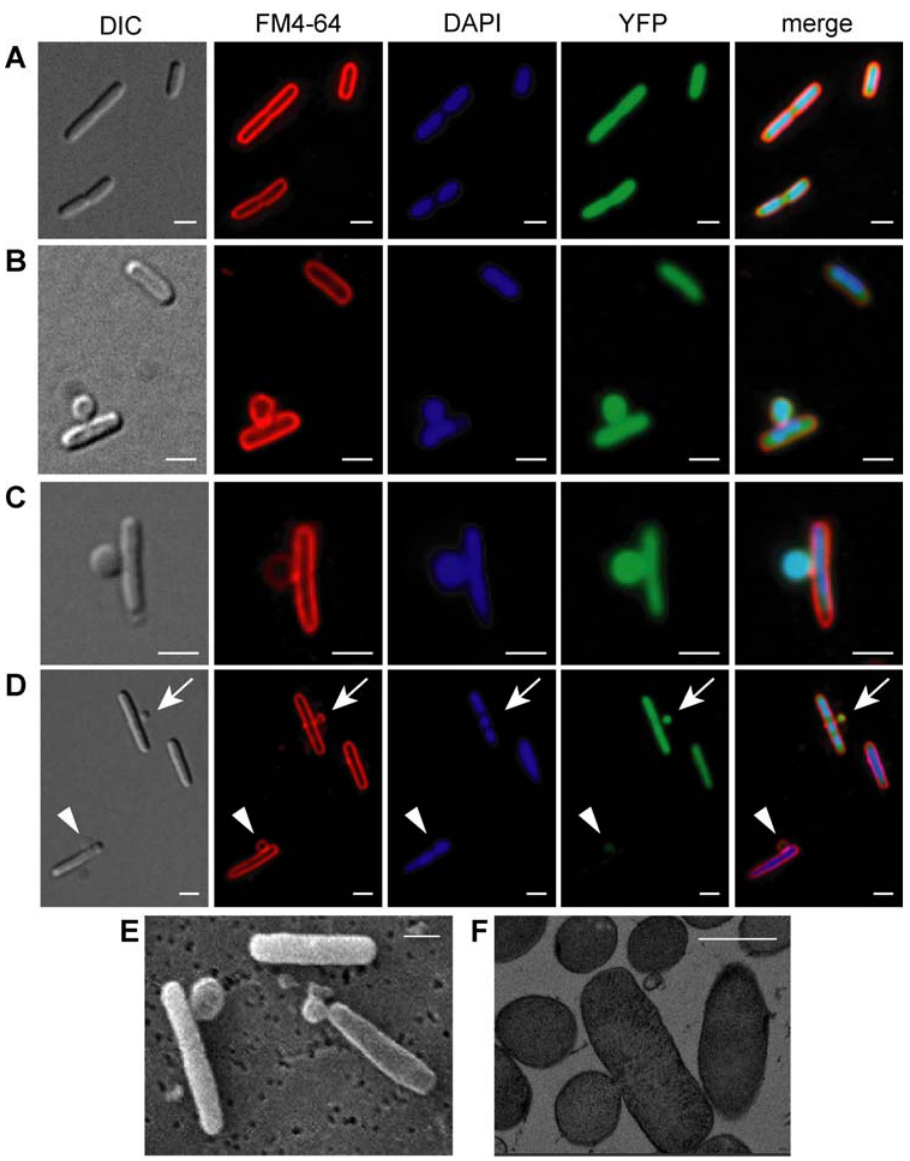
Figure 6. Cell envelope defects resulting from inhibition of s E . Cultures of SEA007 and SEA008 were grown as in Fig. 2. Samples were taken approximately 2.5 hrs. after induction of rseA and rseB overexpression. (A–D) Images of live cells are shown using differential interference microscopy (DIC, column 1) and fluorescence microscopy following addition of FM4-64 to visualize membranes (red, column 2), DAPI to visualize DNA (blue, column 3), and expression of YFP to visualize the cytoplasm (green, column 4). The three fluorescent micrographs are overlaid in column 5. (A) Images of the SEA008 control strain in which s E was not inhibited are shown. (B–D) Images of SEA007 following s E inhibition, reveal blebs that contain YFP and stain with DAPI (B and C) and that contain YFP but do not stain with DAPI (D). In (D), the arrow marks a bleb lacking DAPI staining and the arrowhead marks a lysed cell that retained DAPI staining, but lost YFP. Scale bars are 2 m m. Over 1,000 cells were examined by fluorescence microscopy and typical micrographs are represented here. Scanning electron micrographs (E) and transmission electron micrographs (F) of SEA007 following s E inhibition. Scale bars are 1 m m. No blebs were seen on cells in control cultures.